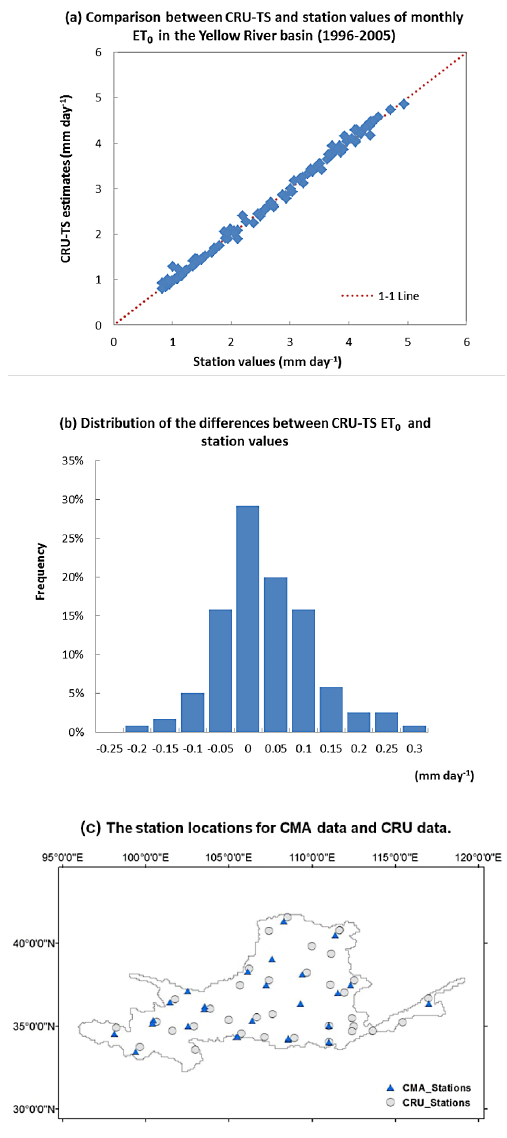
Figure 1. Differences between monthly averages of daily ET 0 data from CRU-TS and station-based values for the Yellow River basin,